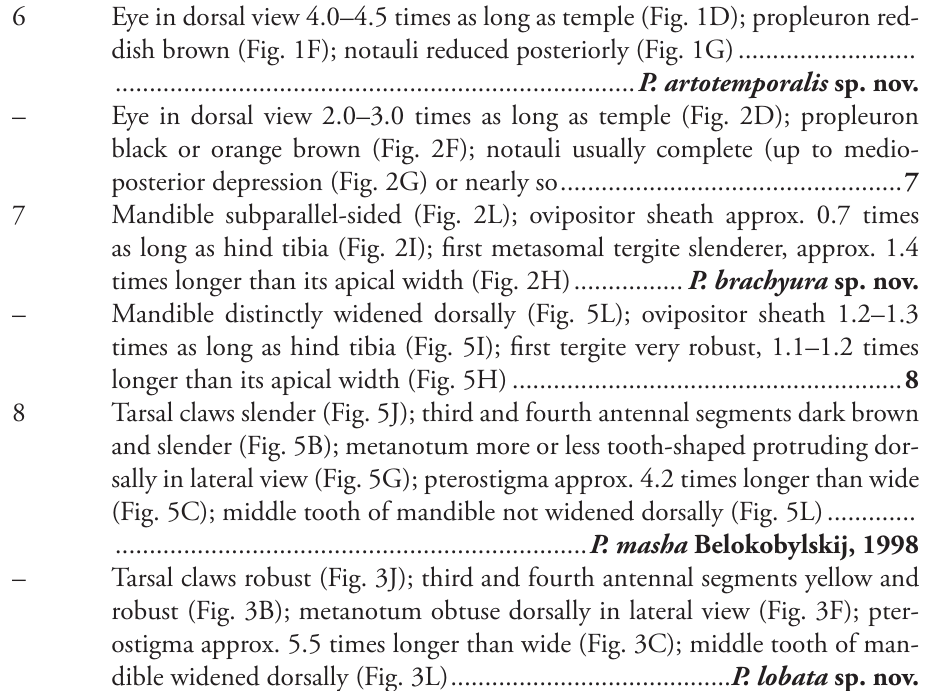
Phaenocarpa artotemporalis Sohn & van Achterberg, sp. nov. http://zoobank.org/D973E619-5FB8-4956-A043-0574073C41EB